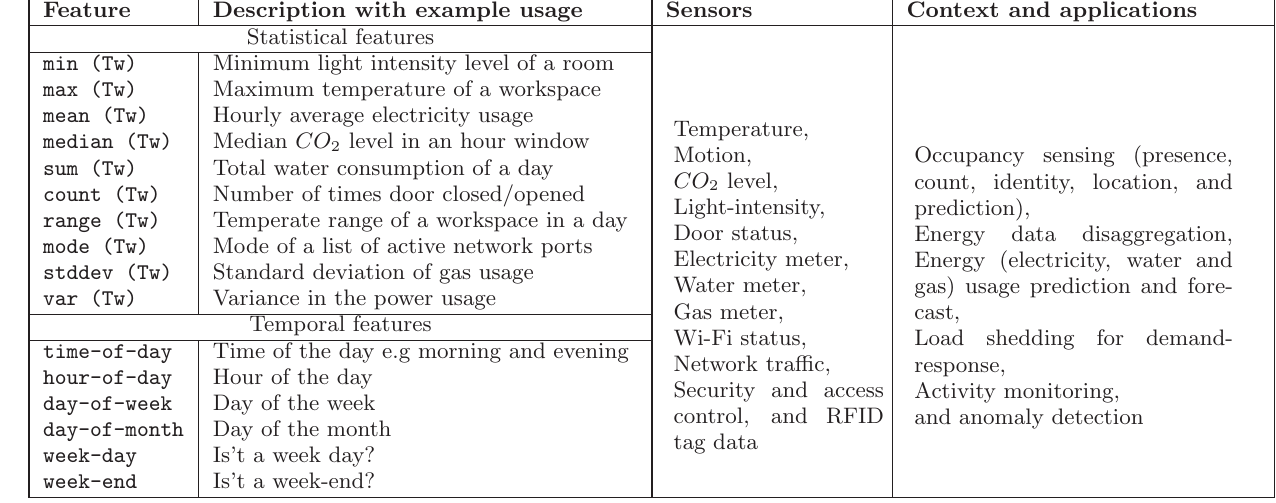
Table 3: List of different categories of features that can be identified from various sensor data streams to infer a wide range of context information of a building. These features are computed for each time window (Tw) spanning a N-seconds interval.